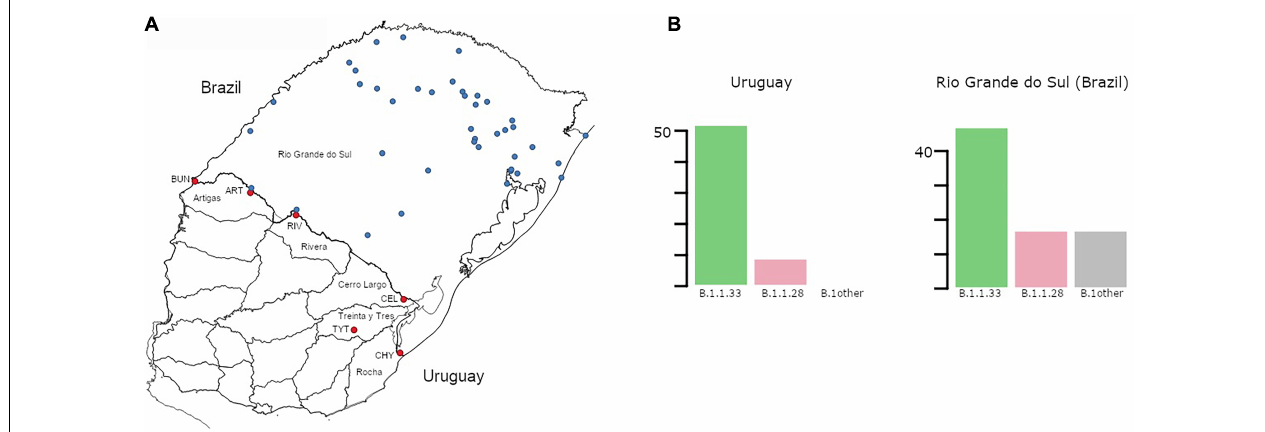
FIGURE 1 | (A) Map of Uruguay and Rio Grande do Sul (Brazil) showing the distribution of samples included in the study. Sampling locations in Uruguay and Rio Grande do Sul (RS) are marked in red and blue, respectively. Uruguayan departments bordering Brazil are explicitly named. Additionally, towns/cities within those departments are marked: BUN, Bella Unión; ART, Artigas; RIV, Rivera; CEL, Rio Branco; TYT, Treinta y Tres; CHY, Chuy. (B) Prevalence (number of cases) of the different SARS-CoV-2 lineages detected in Uruguayan departments at the border region and in RS. While no “B.1other” were found in Uruguay, 6 B.1 and 7 B.1.1 samples were found in RS. The total number of cases for Uruguay was 59 and for RS